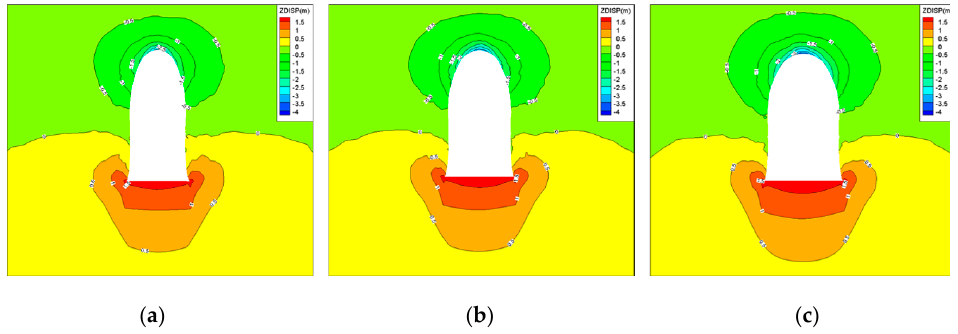
Figure 12. Displacement contours in Z direction with different well spacings after operating for 30